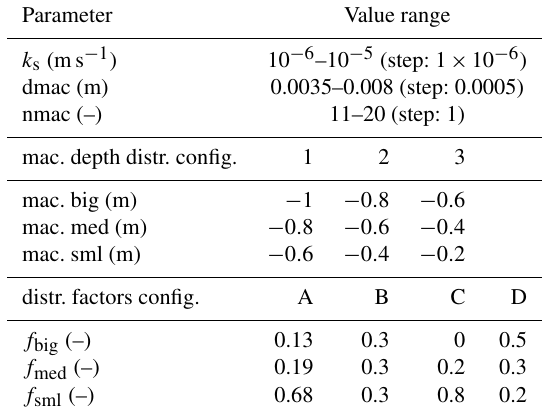
Table 2. Parameter ranges of the sensitivity analyses and configu- rations of macropore depth distribution and distribution factors